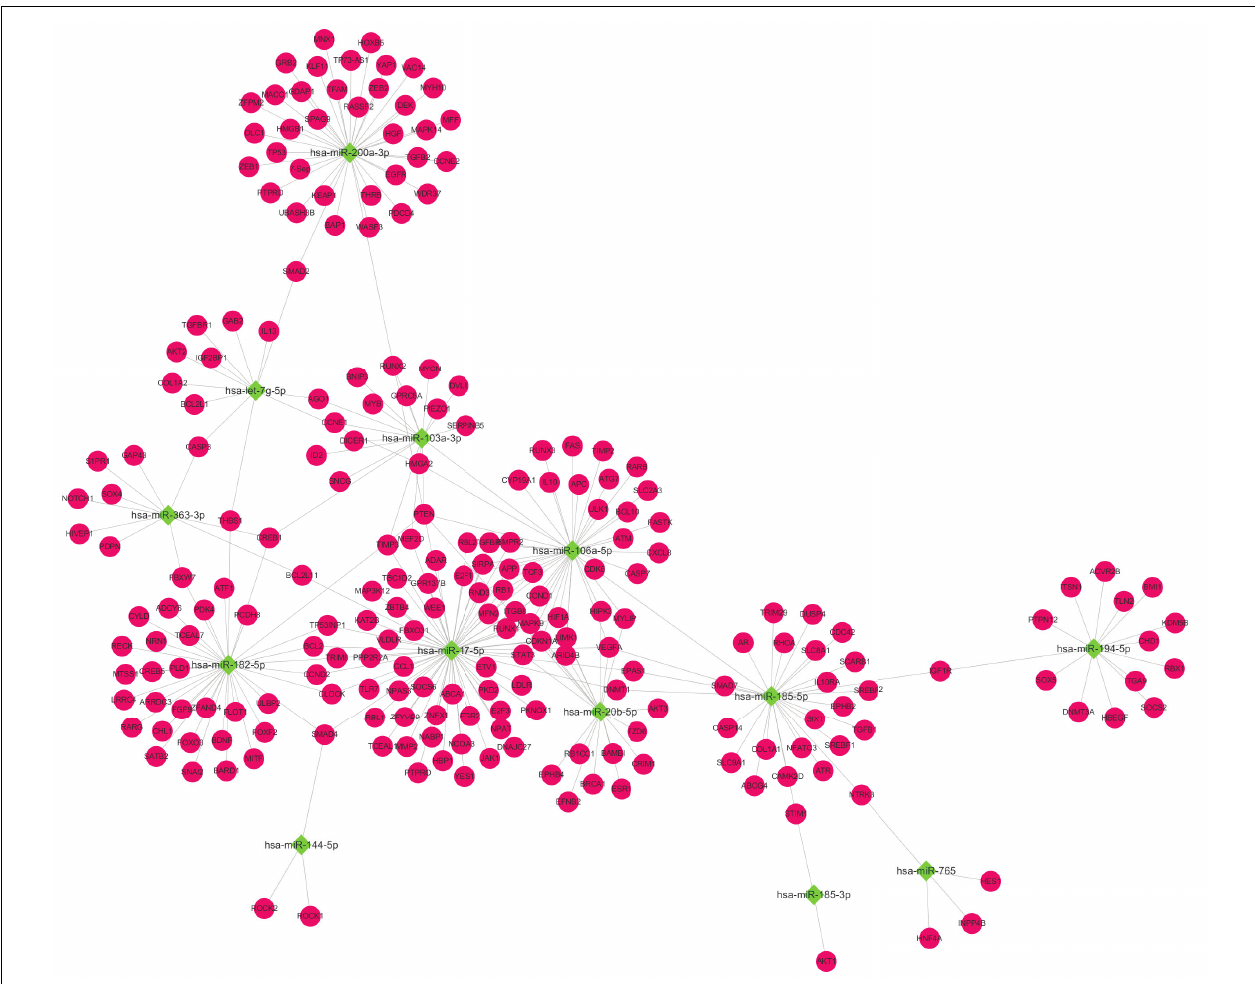
FIGURE 4 | EXO-miRNA and mRNA interaction network analysis. The network targeting on miRNAs which were involved in the PI3K-Akt signaling pathway and their corresponding targets. Green squares and red round nodes indicate miRNAs and mRNAs,